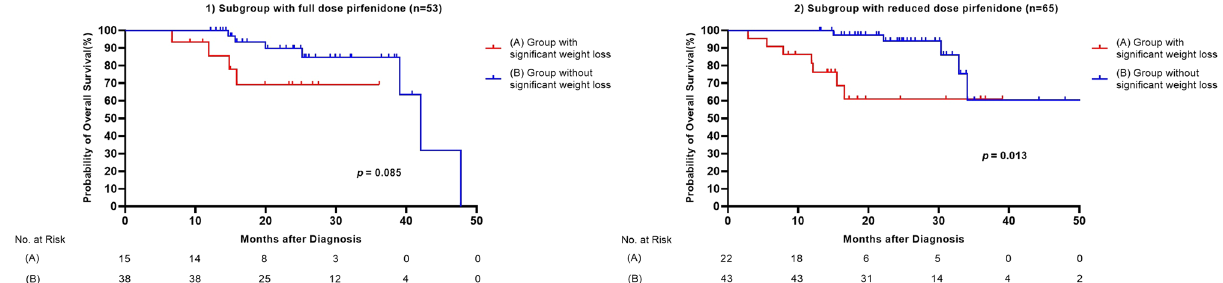
Figure 2. ( 1 ) Comparison of survival curves between groups with and without significant weight loss in a subgroup with full-dose pirfenidone (A) Group with significant weight loss, (B) Group without significant weight loss. ( 2 ) Comparison of survival curves between groups with and without significant weight loss in a subgroup with reduced dose pirfenidone (A) Group with significant weight loss, (B) Group without significant weight